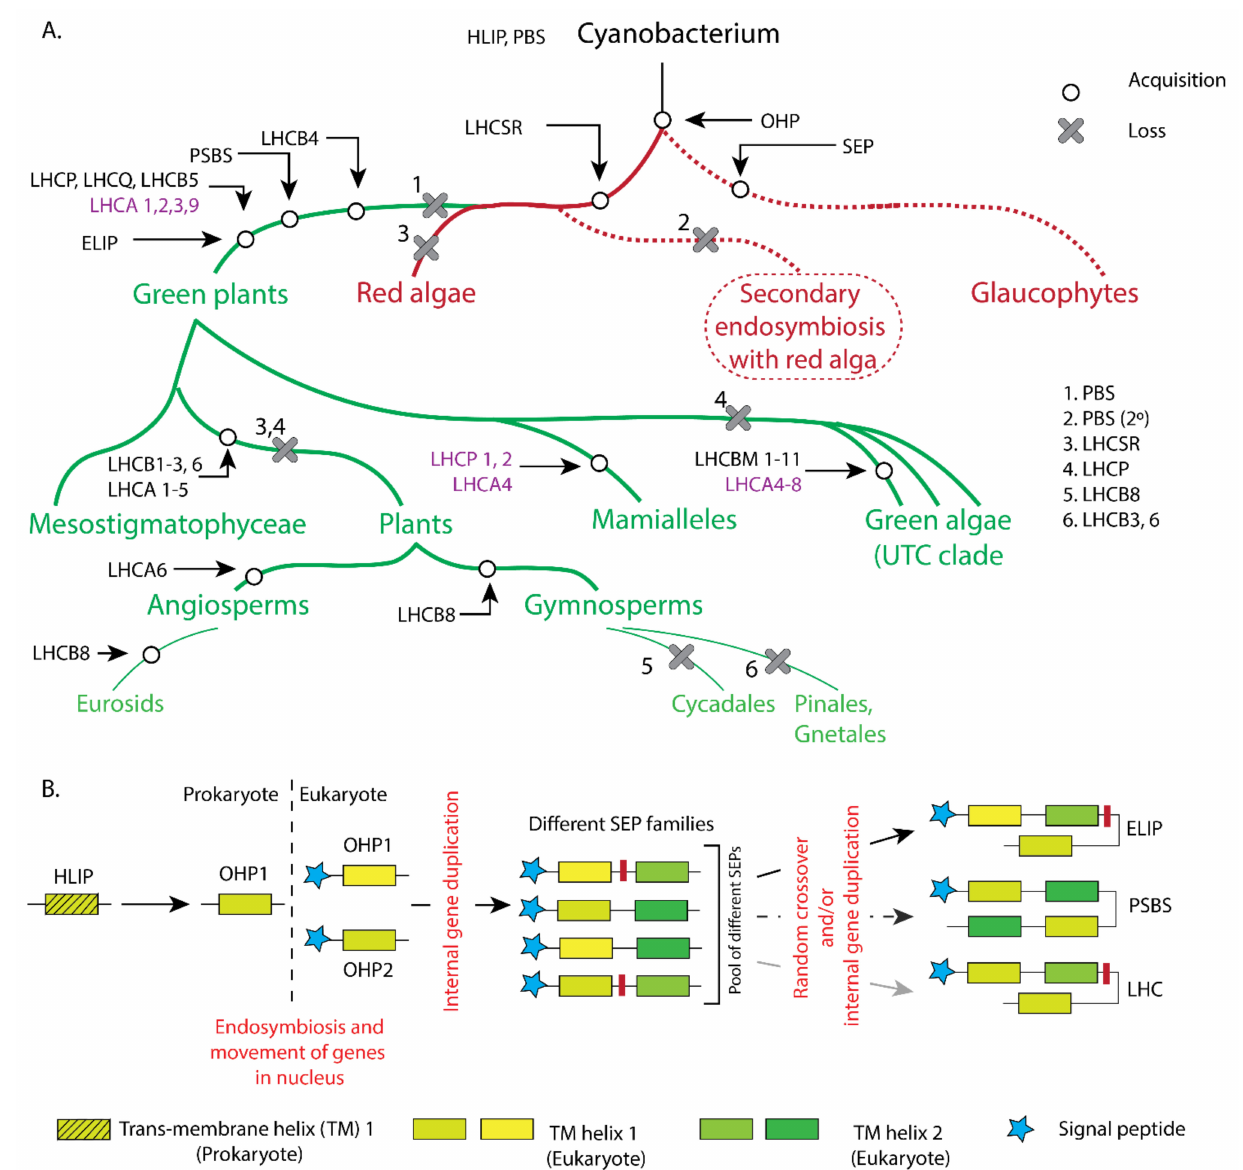
Figure 1. The evolution of the light-harvesting antenna proteins across the photosynthetic lineage from cyanobacteria to higher plants. ( A ) The loss and gain of the different light harvesting proteins and their homologues during the evolution of the photosynthetic lineage. Proteins (in magenta) share a similar genetic background, but are slightly different from each other, such as algae type LhcAs (in magenta) that are slightly different from the plant type LhcAs (in black). ( B ) Genetic events that may have occurred during evolution to give rise to higher plant antennae from their prokaryotic ancestors. The evolution of ELIP, PsbS and Lhc from different SEP families occurred via independent